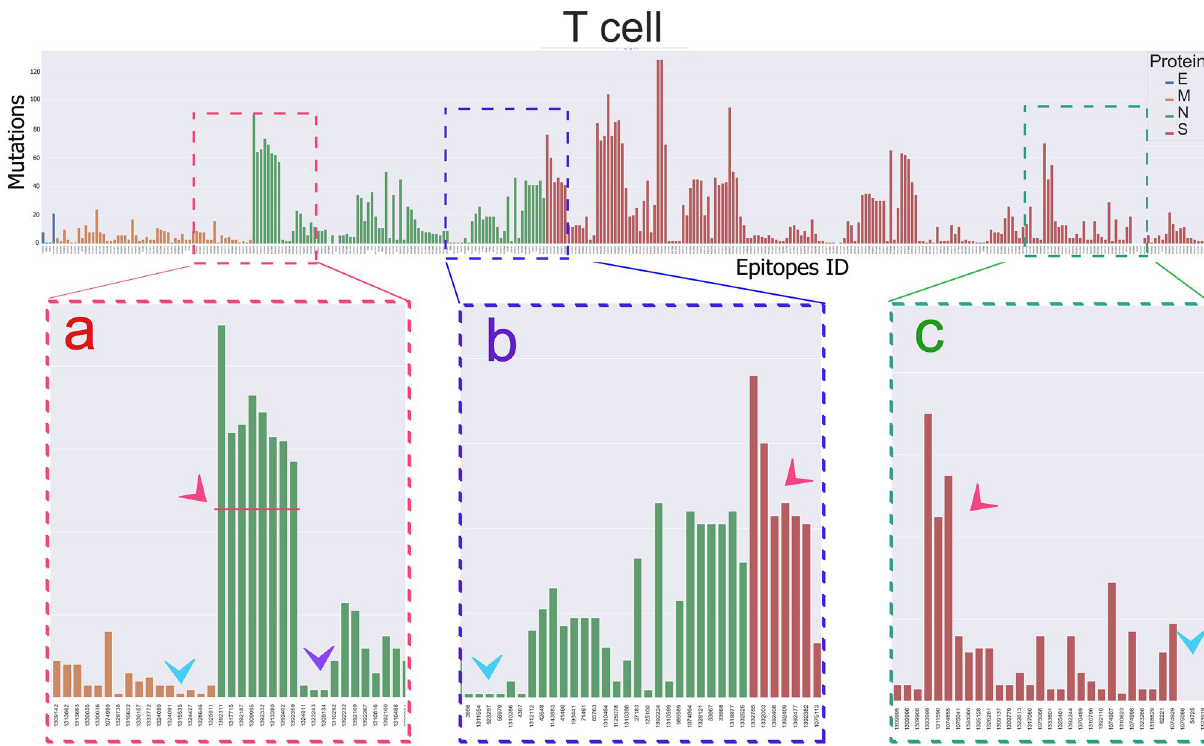
Figure 6. Mutational diagram (MD); Illustration of IEDB epitopes and their mutations. In this figure number of mutations is illustrated in vertical bars and epitopes ID is under each bar in horizontal axis. Panel ( a – c ) magnifies 3 different parts of MD. For example, in panel ( a ) there are epitopes from M protein (orange bars) that have a small number of mutations (sky blue arrows head) besides, epitopes from N protein (green bars) with the high number of mutations (pink arrows head). Purple arrows head point to sites with a moderate amount of